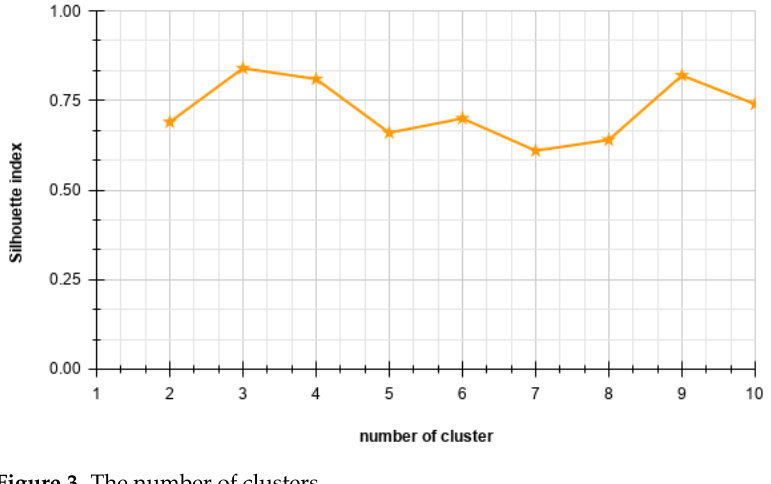
Figure 3. The number of